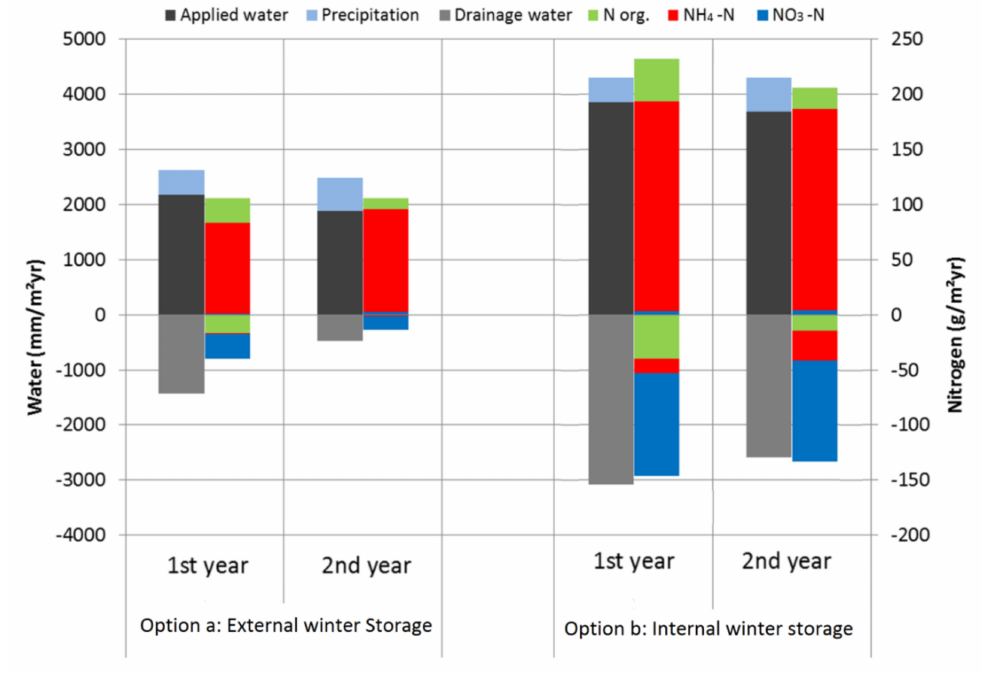
Figure 5. Annual water balance and nitrogen composition of the application and drainage waters within the beds.